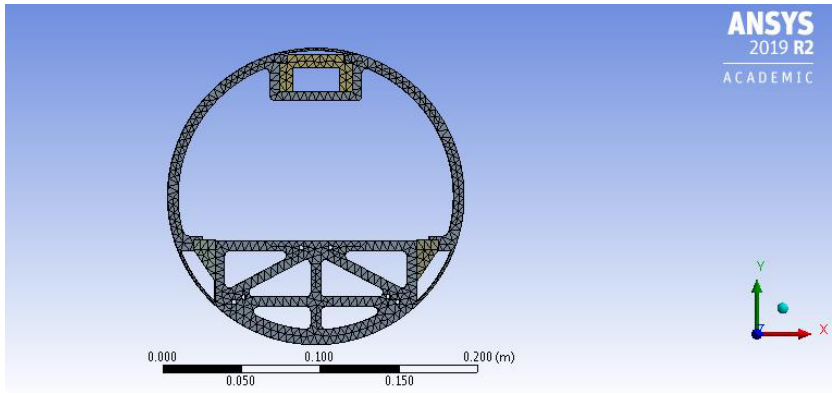
Figure 16. Most refined mesh used for the shell with sliding stiffeners: front view of the stiffening